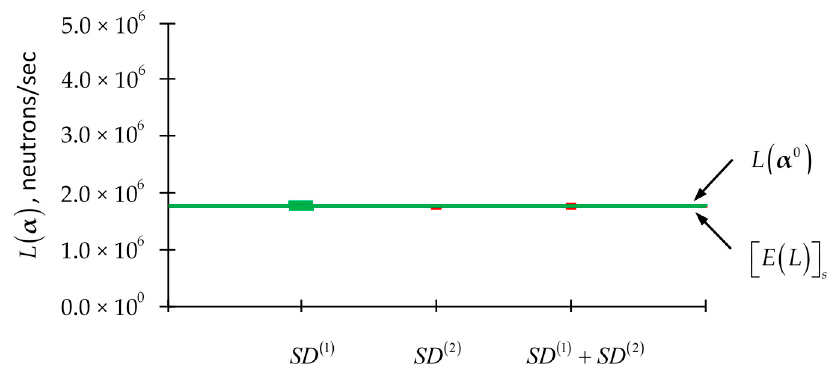
(cid:16) (cid:17) ± SD ( 1 ) (in green), [ E ( L )] α 0